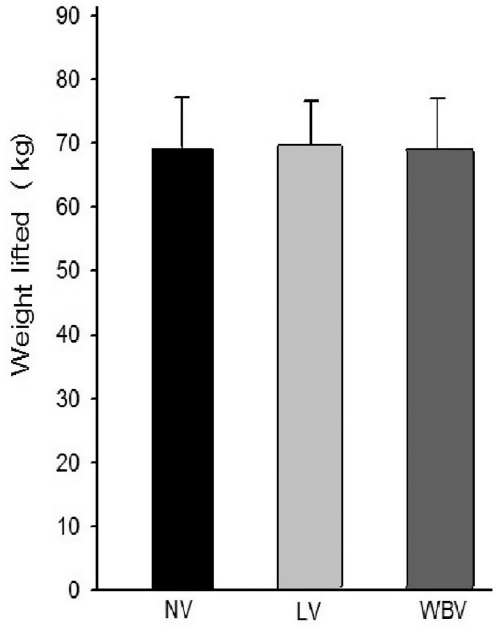
Figure 5 - Weight lifted during the 1RM test. NV = No vibration; LV = Local Vibration; WBV = whole body vibration. Vertical lines = standard